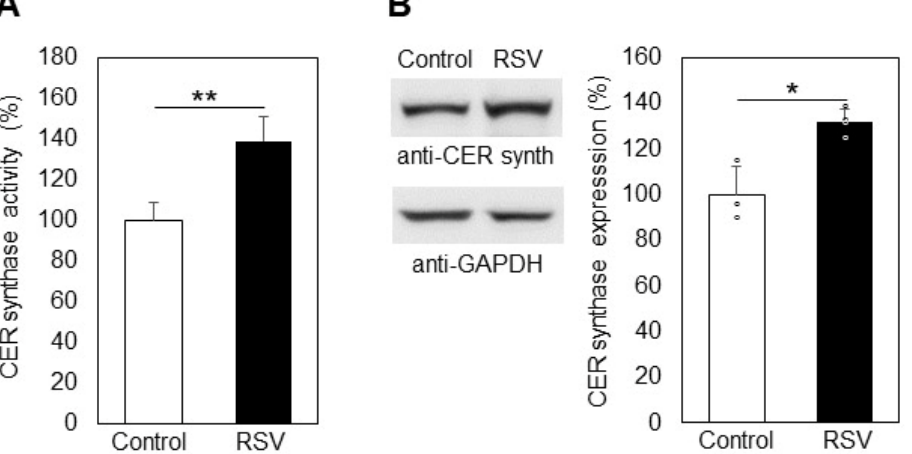
Figure 5. Alteration in the activity ( A ) and the expression ( B ) of ceramide synthase 6 in control (Control, white bars) and resveratrol-treated (RSV, black bars) A549 cells. Values are expressed as % of controls (100%). Representative images from immunoblotting obtained with antibodies against ceramide synthase (anti-CER synth) are shown on the left part of panel B. Reaction with anti-glyceraldehyde-3-phosphate dehydrogenase antibodies (anti-GAPDH) was used as an internal control for loading. Graphical depiction of the percent change in CER synthase expression is presented on the right part of panel B; ( ᵒ ) stands for the values from each independent experiment, obtained by pooling of three replicate samples. Values represent means ± S.D. * p < 0.01, ** p < 0.001.